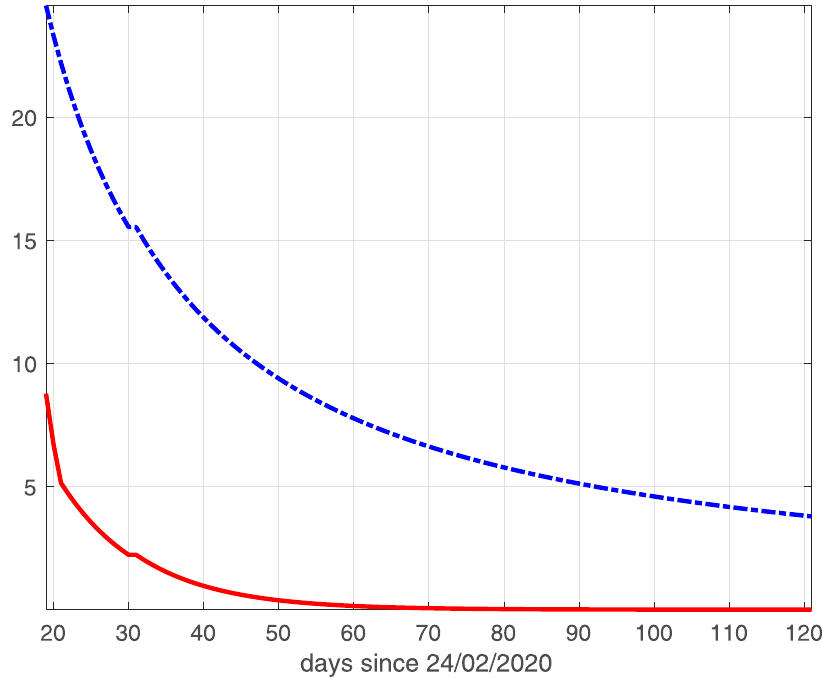
Fig 14. Reproduction function in Lombardia. R ð t Þ predicted until 24/06/2020 after the calibration of fSEIRDe (red continuous line) and fSEIDRr (blue dash-dotted line) on the data in the period [24/02-27/03].